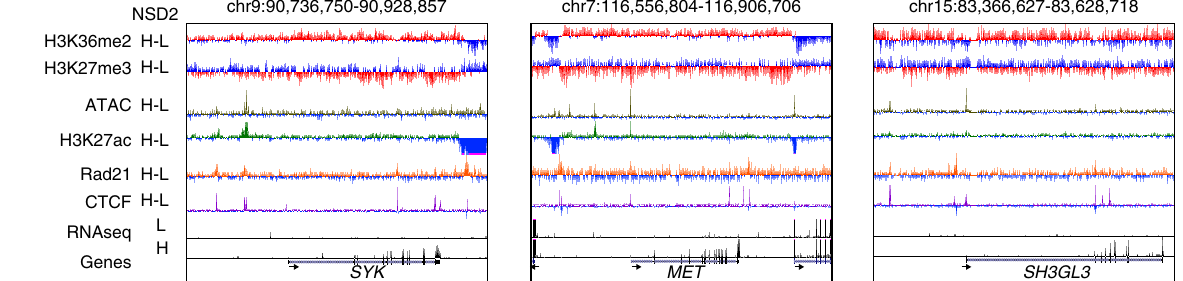
Fig. 2 New CTCF and H3K27ac peaks are located within expanded H3K36me2 domains. a Violin plot (left panel) and heatmap (right panel) showing signi fi cant NSD2-mediated changes in CTCF binding ( n = 3 independent experiments, FDR < 0.01, Wald test). Increasing peaks: 1650 (red, log2-fold change > 1); decreasing peaks: (blue, log2-fold change < − 1). b Genomic locations of differential CTCF peaks using ChIPseeker (promoter: − / + 3kb around TSS). c Gene expression changes are associated with CTCF changes (upreg. and downreg.: upregulated and downregulated genes), at promoters (middle panel) and distal CTCF sites (bottom panel). CTCF up, down and stable are, respectively, shown as red, blue and gray in NSD2 High versus Low cells. Source data are provided as a Source Data fi le. d Heatmaps of H3K27ac, H3K36me2, H3K27me3, ATAC-seq, Rad21, and CTCF signal at the top 1000 increased H3K27ac and CTCF peaks in NSD2 High cells (top and bottom panels, respectively). Peaks were ranked by H3K27ac and CTCF signal in NSD2 High cells. e UCSC genome browser screenshots of chromatin features at regions surrounding three oncogenes ( SYK , left panel; MET , middle panel; and SH3GL3 , right panel). H-L refers to subtraction of the ChIP-seq signal (NSD2 High – Low)